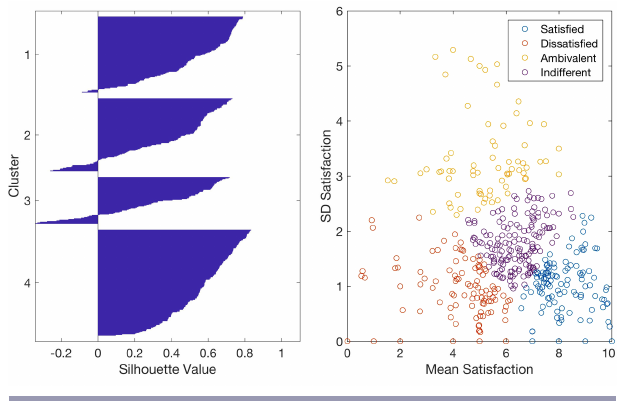
Fig. 3 . K-means clustering of individuals based on magnitude and standard deviation of reported life satisfaction. Silhouette